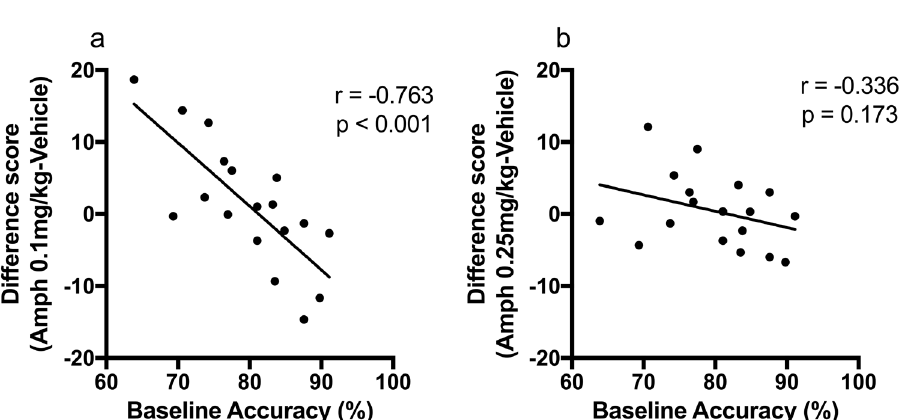
Figure 2. Performance accuracy after amphetamine. ( a ) The reduced accuracy observed in the low performing group after vehicle was corrected by 0.1 mg/kg amphetamine, but not by 0.25 mg/kg amphetamine. ( b ) A difference score was calculated to compare accuracy after vehicle and amphetamine, demonstrating a significant difference between low and high performing rats in response to 0.1 mg/kg amphetamine and 0.25 mg/kg amphetamine ( n = 8–10), * p < 0.05.